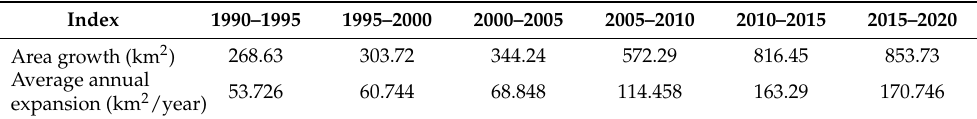
Table 2. Change in urban built-up area in Central Plains urban agglomeration.